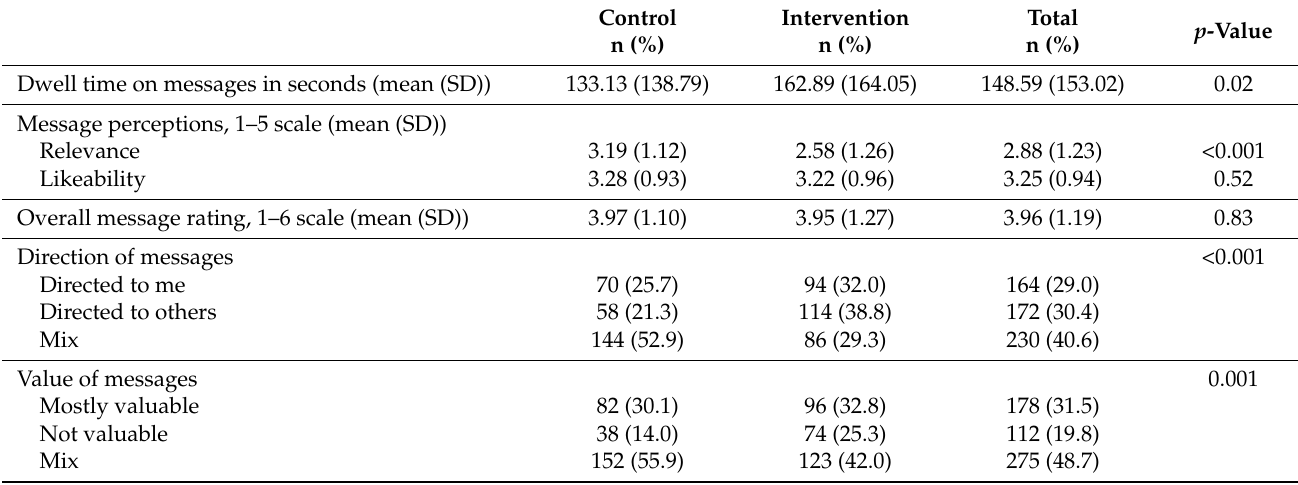
Table 2. Message response, by study condition, PACE Vape Messaging Study,